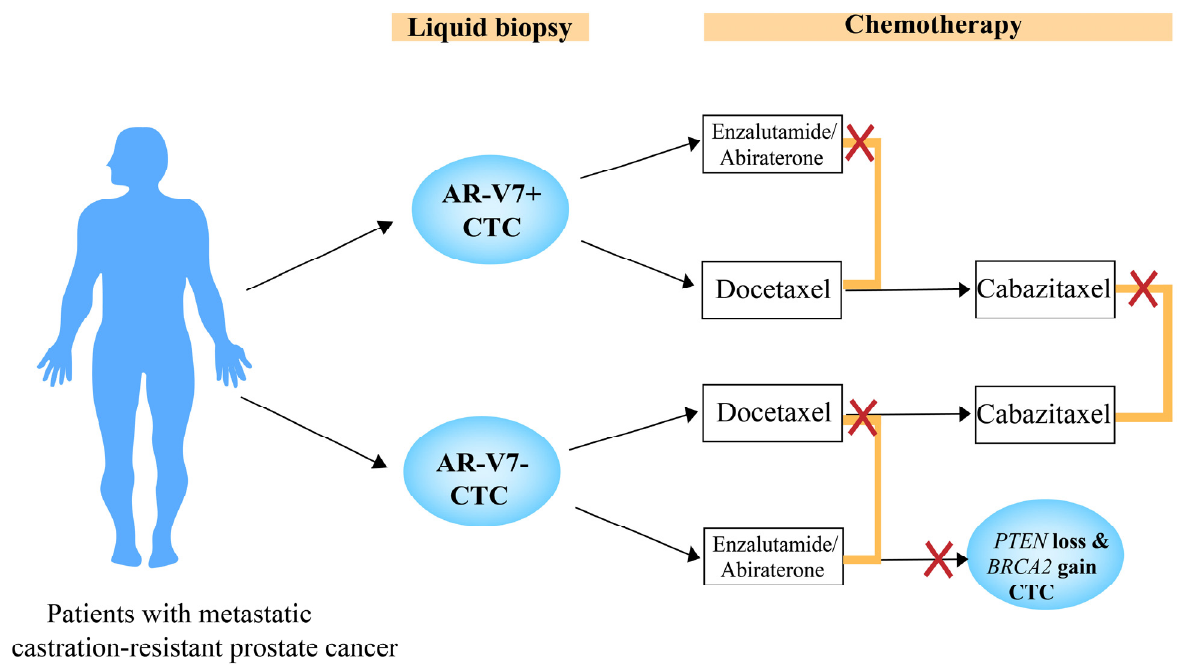
Figure 3. AR-V7 (androgen receptor V7) as an indicator of chemotherapy in patients with metastatic castration-resistant prostate cancer (mCRPC). mCRPC patients who have pretherapy AR-V7-positive circulating tumor cells (CTCs) are associated with poorer outcomes for enzalutamide/abiraterone over taxanes. However, mCRPC patients who have pretherapy AR-V7-negative CTCs are associated with better outcomes on enzalutamide/abiraterone; subsequently, the alterations of PTEN loss and BRCA2 gain in CTCs indicate worse outcomes. In addition, cabazitaxel at a lower dose is associated with poorer outcomes after docetaxel in AR-V7-positive patients, compared to AR-V7-negative patients. Note that this figure should not be used for clinical decision-making.